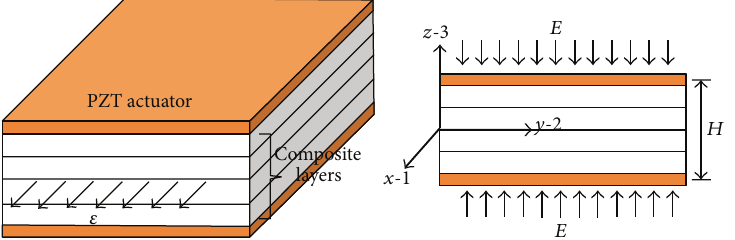
Figure 1: Geometry of laminated composite plate with surface bonded piezoelectric actuators under combined electromechanical loadings.